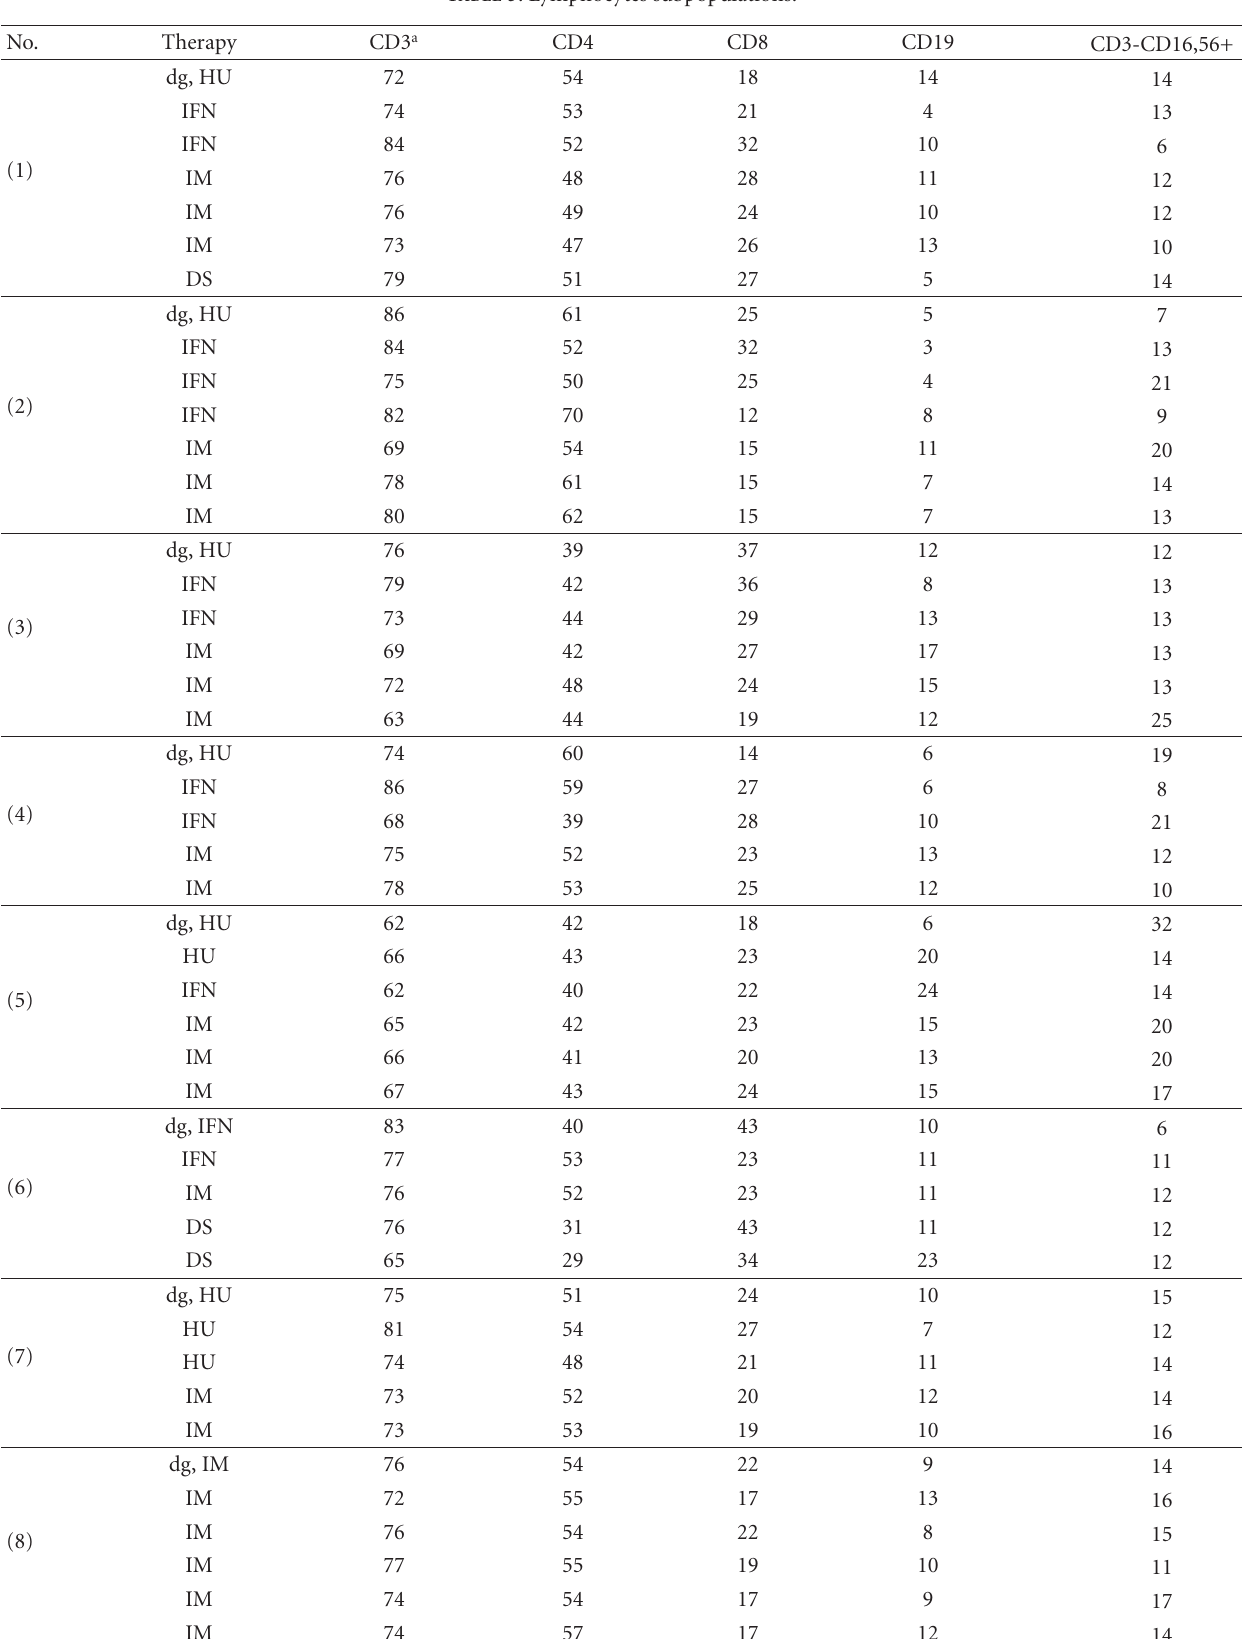
Table 5: Lymphocytes